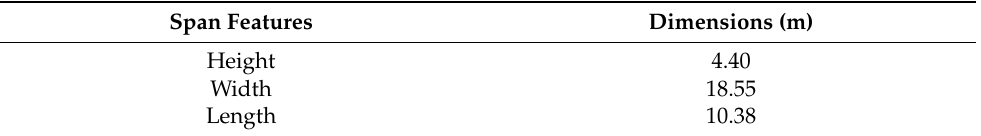
Table 1. “Bridge A” geometry and dimensions: height from Morra Creek bed (m), span width (m), and length (m).